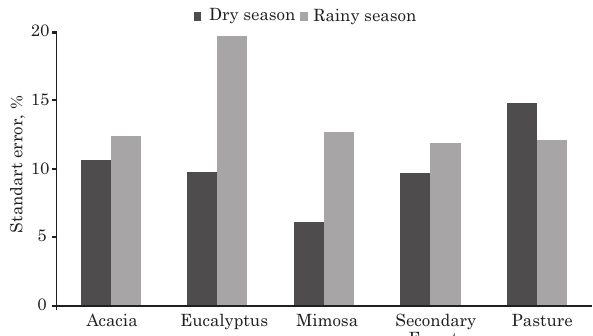
Figure 1. Seasonal variation of the standard error of total abundance of the soil fauna in Acacia mangium (acacia), Mimosa artemisiana (mimosa), Eucalyptus grandis x E. urophylla (eucalyptus) stands, pasture, and secondary